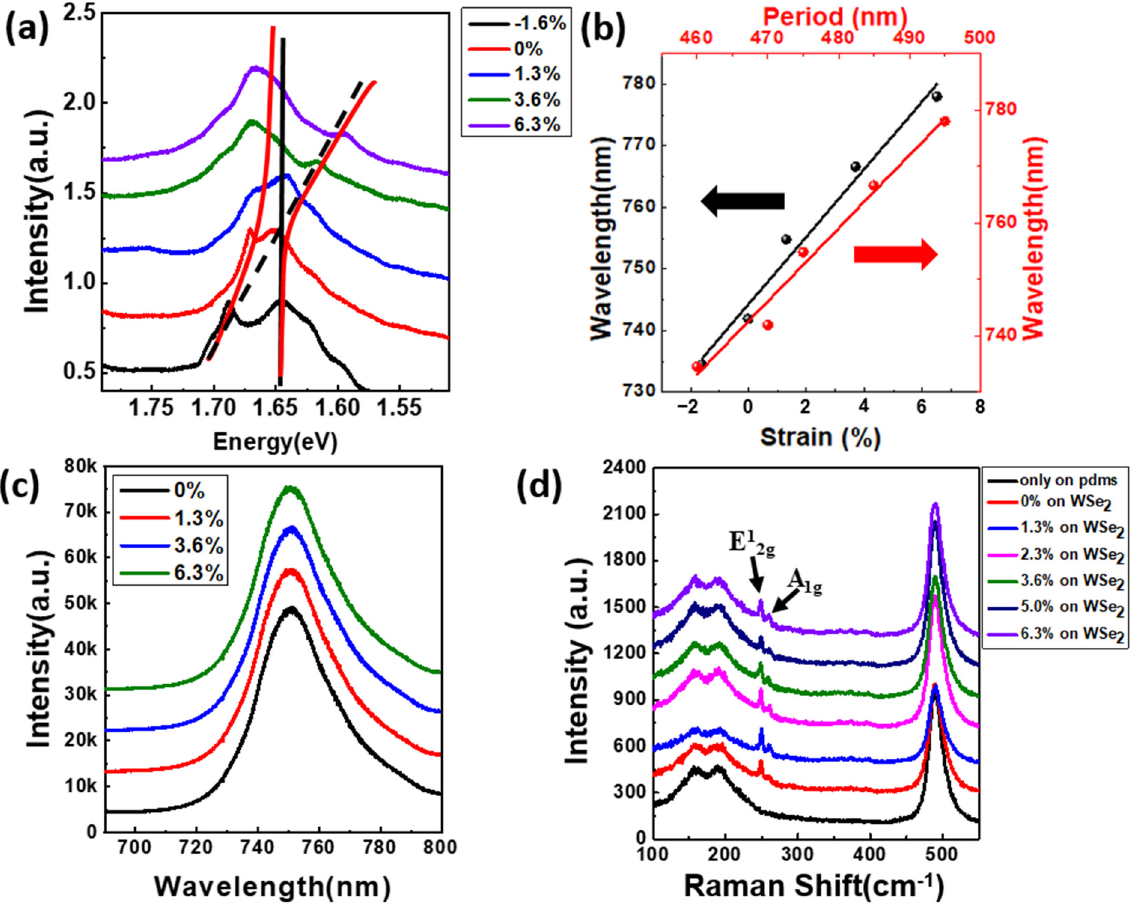
Figure 7. ( a ) PL spectrum of the PhC structure integrated with WSe 2 for various strains. ( b ) Wave- length shift with strain and period. ( c ) PL spectra of WSe 2 with different strains. ( d ) Raman spectra of WSe 2 with different strains.